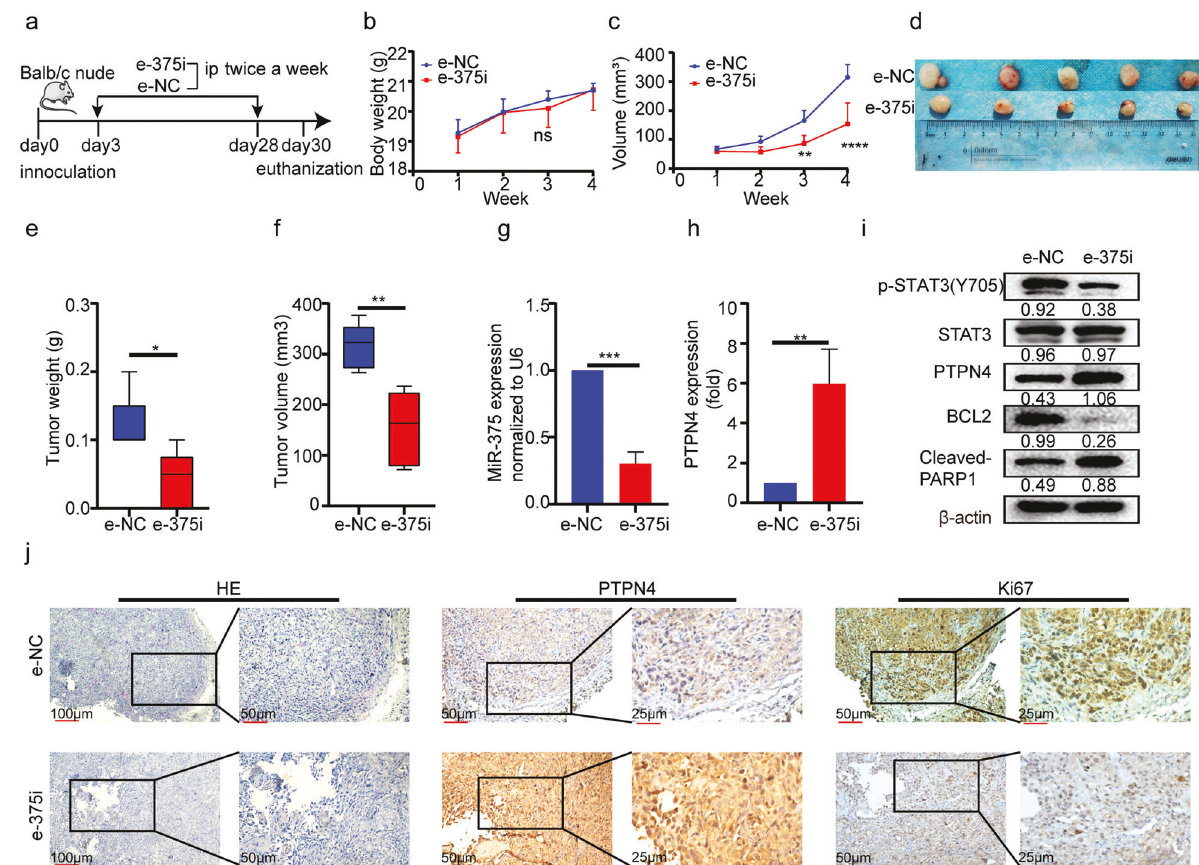
Fig. 7 E-375i inhibited PCa proliferation in vivo. a The fl ow chart showing the study design. b The bodyweight of the animals and c the tumor volume during the follow-up. d Representative images of tumors, e tumor weight, and f tumor volume at the endpoint of observation. g The expression of miR-375 and h mRNA level of PTPN4 were tested by qRT-PCR in endpoint tumor tissues. i Western blot showing the expression of p-STAT3, PTPN4, BCL2 and cleaved-PARP1 in tumor tissues. j IHC analysis of the expression of PTPN4 and Ki67 in the two (Supplementary Fig. 7e). The exosomes were coincubated with miR-375 antisense PMO to form the e-375i complex at room temperature. Next, we determined whether the miR-375i PMO could be transferred into PCa cells by exosomes. As shown in Supplementary Fig. 7f, PKH67-labeled exosomes (green) could be ef fi ciently internalized by PCa cells. Treatment with e-375i signi fi cantly inhibited miR-375 levels and p-STAT3 but upregu-